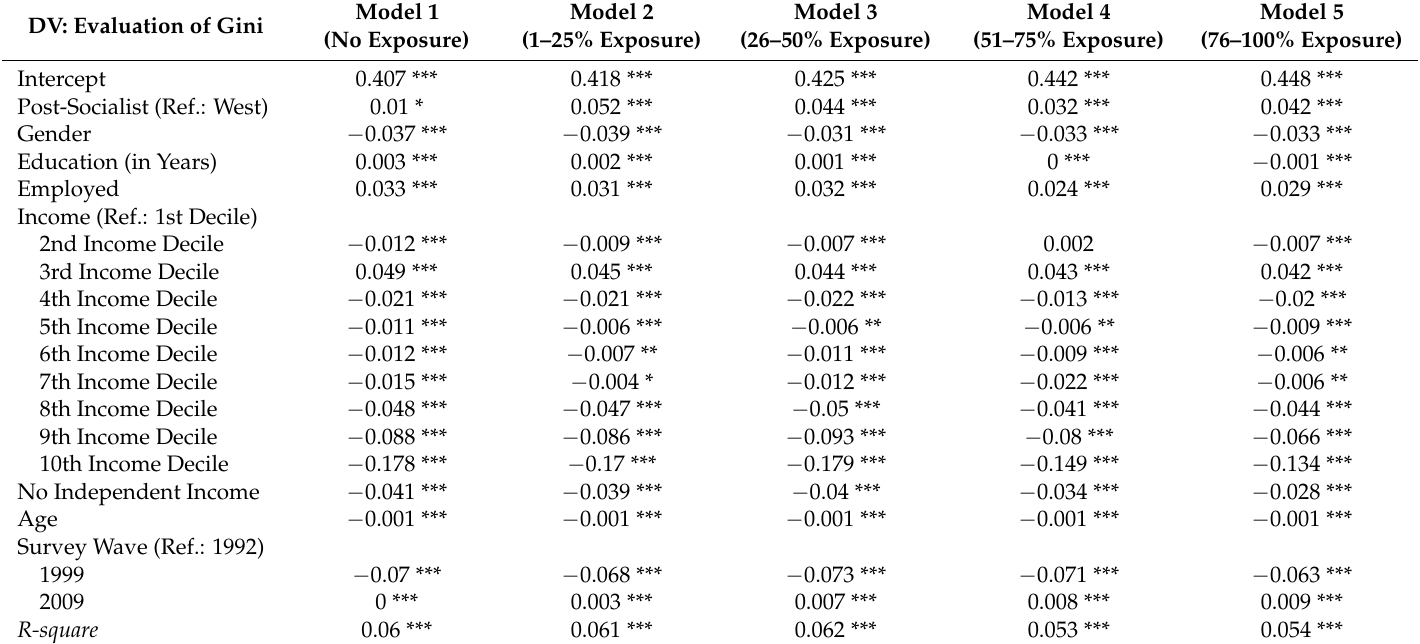
Table A5. Bootstrapped OLS regression models to explain the evaluation of Gini by exposure rate (corresponding with Figure 2b). Model 1 Model 2 DV: Evaluation of Gini (No Exposure) (1–25% Exposure) Intercept 0.407 *** Post-Socialist (Ref.: West) 0.01 *